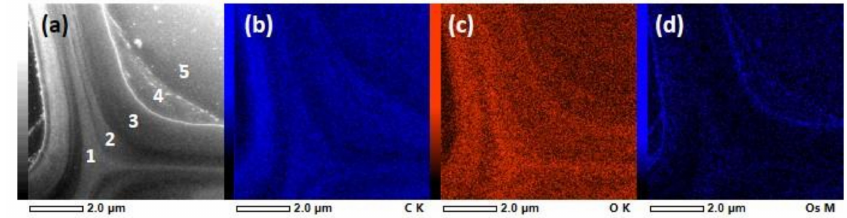
Figure 8. STEM-EDS of the resin-embedded knotwood tracheid’s cell wall structure. ( a ) STEM image with region numbers corresponding to Table 5. EDS images showing ( b ) C K α , ( c ) O K α and ( d ) Os M α X-ray emission. Table 4. Element composition of the resin-embedded tracheid regions measured with STEM-EDS (Figure 7). Atom–% Mass–% C O Os